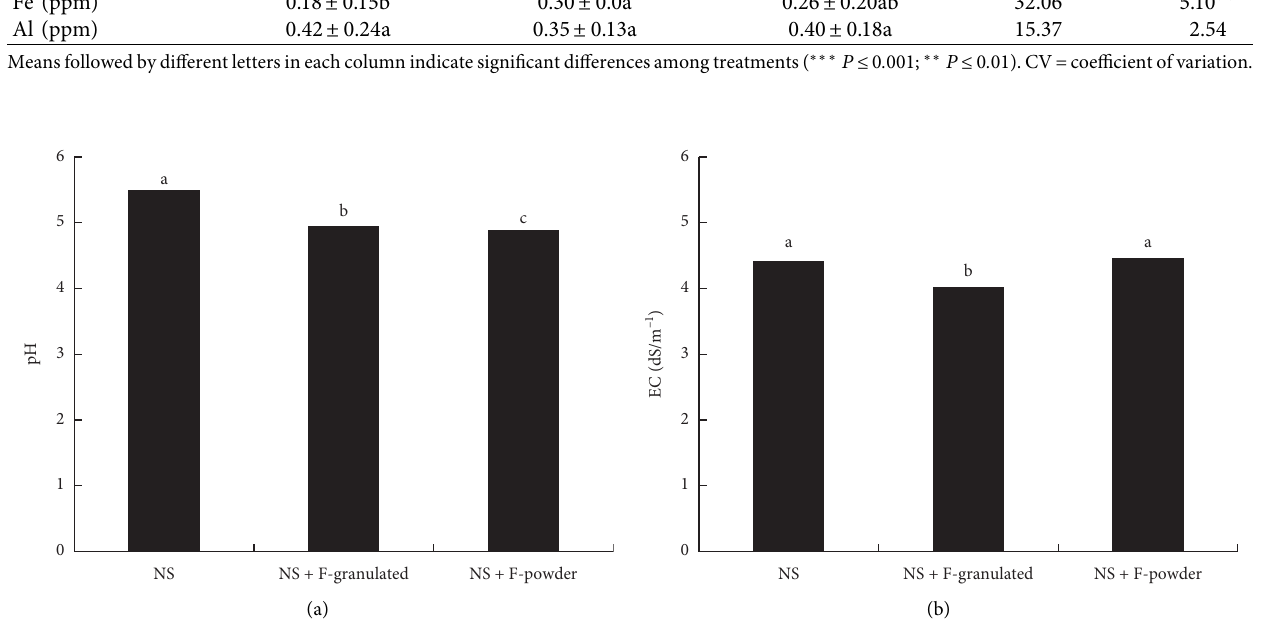
Figure 2: Effect of variations in NS, NS +F-granulated, and NS +F-powder on pH and electrical conductivity (EC) values (dS · m − 1 ) of tomato cherry fruit. Data shown represent an average of nine replicates. Different letters represent significance according to Tukey’s test ( ∗∗ P ≤ 0 .